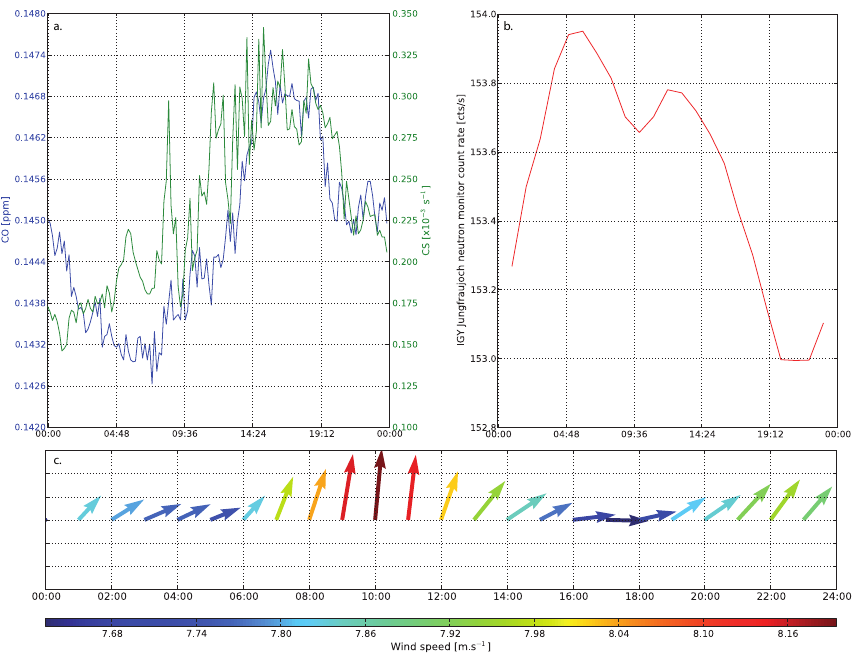
Fig. 2. (a) Mean diurnal variation of carbon monoxide (blue) and condensational sink (green) ( left panel ), (b) neutron monitor count rate (red) ( right panel ) and (c) wind direction and speed ( bottom panel